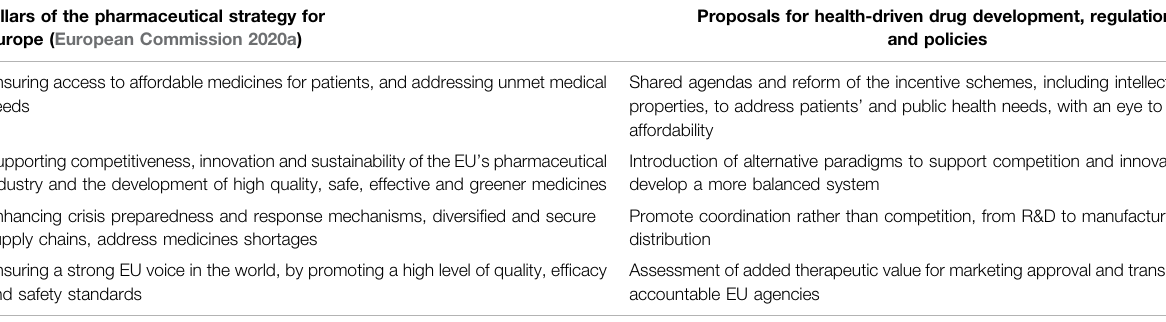
TABLE 1 | Pillars of the pharmaceutical strategy and key